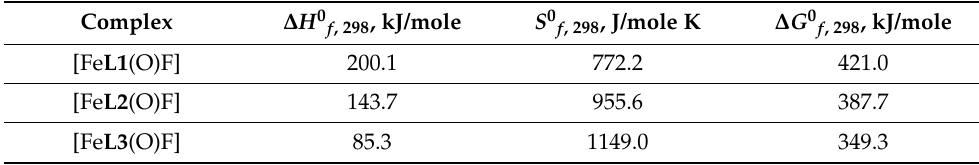
Table 3. Standard thermodynamic parameters of formation (enthalpy ∆ f H 0 , entropy S 0 and Gibbs’s energy ∆ f G 0 ) for the complexes having [Fe L1 (O)F], [Fe L2 (O)F] and [Fe L3 (O)F] compositions calcu- lated using DFT OPBE/TZVP